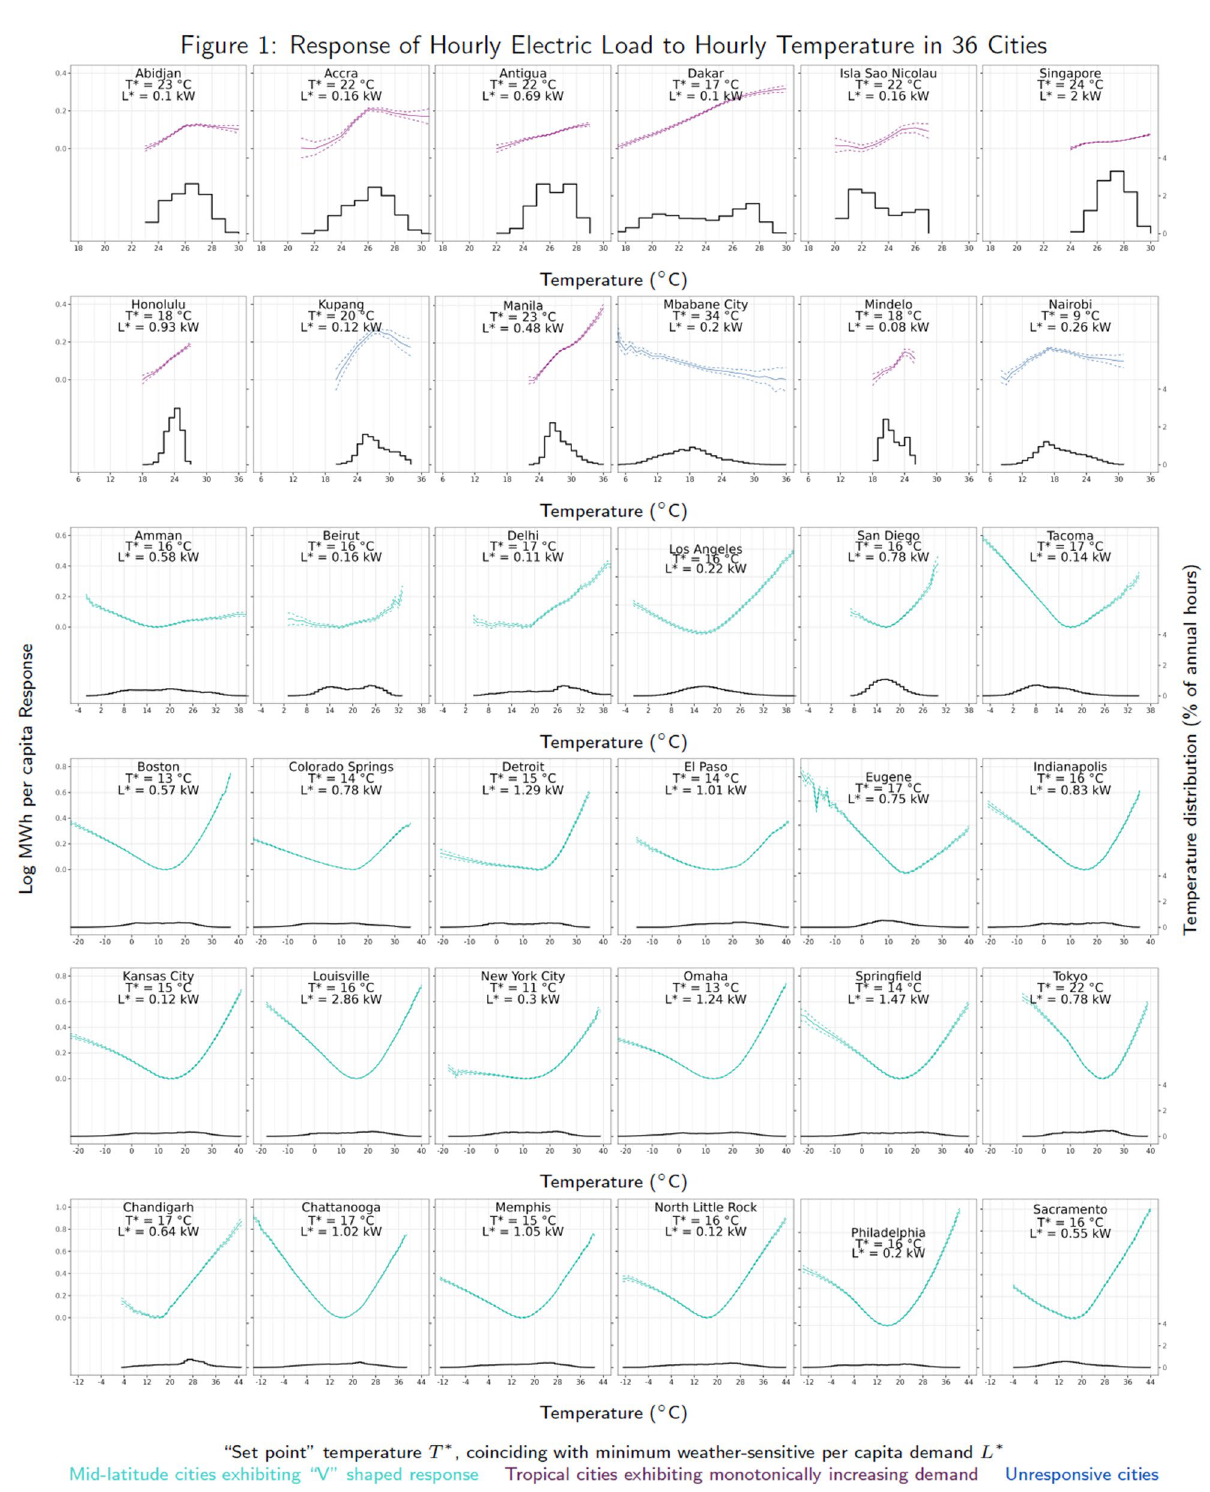
Figure 2. Response of hourly electric load to hourly temperature in 36 Figure 4 summarizes the consequent net impacts of climate change on the total and peak demand for electric- ity (Fig. S8 illustrates these impacts under RCP 4.5. Relative to the current climate, the change in annual demand per capita at the multi-model median ranges from − 2.7 to + 5.7 % (Panel a), while the change in the multi-model median of the 95th percentile of hourly demand ranges from − 3.4 to + 9.5 % (Panel b). In the majority of our sample of cities, the amplifying effect of the semi-elasticity of demand to hot temperatures ( T > T ∗ ) in conjunc- tion with climatically-induced increases in hot hours outweighs the attenuating effect of the semi-elasticity of